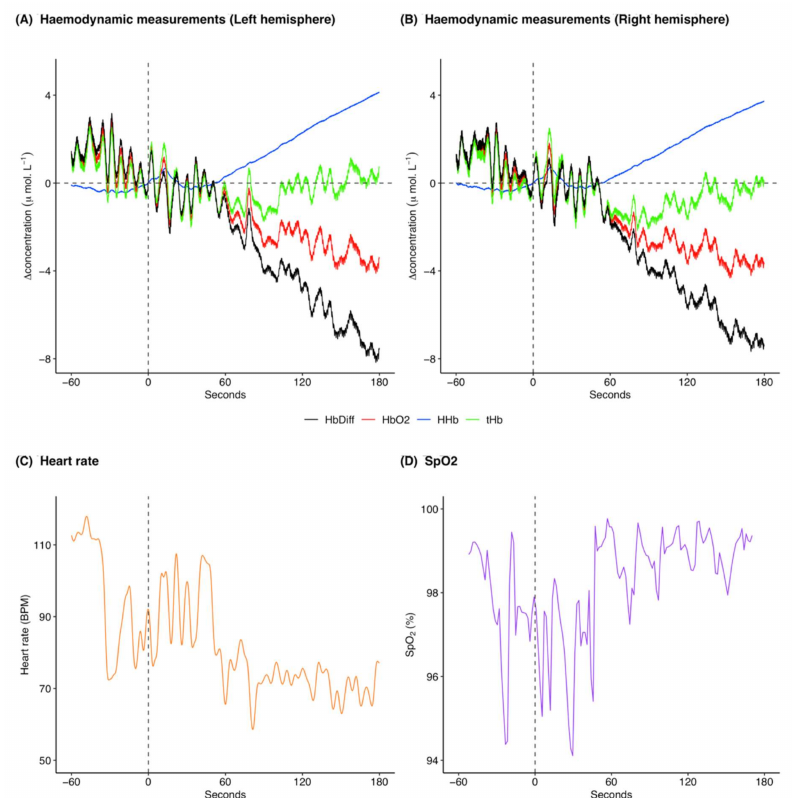
1.4 µ mol L − 1 and range: − 0.3 to 4.1 µ mol L − 1 ), whereas [ ∆ O 2 Hb] decreased (Figure 2A,B; pre-administration mean: 0.9 µ mol L − 1 and range: − 0.7 to 2.9 µ mol L − 1 , post-administration mean: − 1.9 µ mol L − 1 and range: − 4.3 to 1.8 µ mol L − 1 ). [ ∆ tHb] was initially decreasing and then increased following ketamine administration (Figure 2A,B; pre-administration mean: 0.6 µ mol L − 1 and range: − 1.0 to 2.6 µ mol L − 1 , post-administration mean: − 0.4 µ mol L − 1 and range: − 2.2 to 2.5 µ mol L − 1 ). [ ∆ Hb diff ] decreased following ketamine administration (Figure 2A,B; pre-administration mean: 1.1 µ mol L − 1 and range: − 0.7 to 3.2 µ mol L − 1 , post-administration mean: − 3.3 µ mol L − 1 and range: − 8.2 to 1.5 µ mol L − 1 ). The left and right hemispheres (Figure 2A,B) showed the same trends for the haemodynamic vari- ables with marginal differences in exact values of measurements. Heart rate was variable throughout the analysed time frame, although heart rate variation decreased following ketamine administration (Figure 2C; pre-administration mean: 95.8 BPM and range: 72.4 to 117.9 BPM, post-administration mean: 78.3 BPM and range: 58.6 to 107.5 BPM). Addi- tionally, heart rate generally decreased following ketamine administration. SpO 2 remained high throughout the analysis window (Figure 2D; pre-administration mean: 97.8% and range: 94.4 to 99.4%, post-administration mean: 98.3% and range: 94.1 to 99.8%).